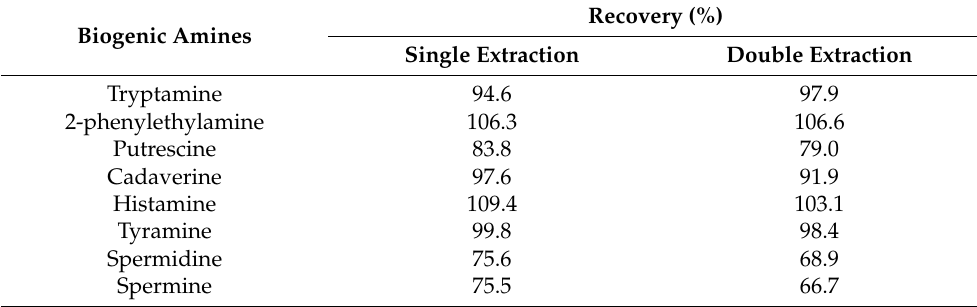
Table 1. Results of the optimization on the number of